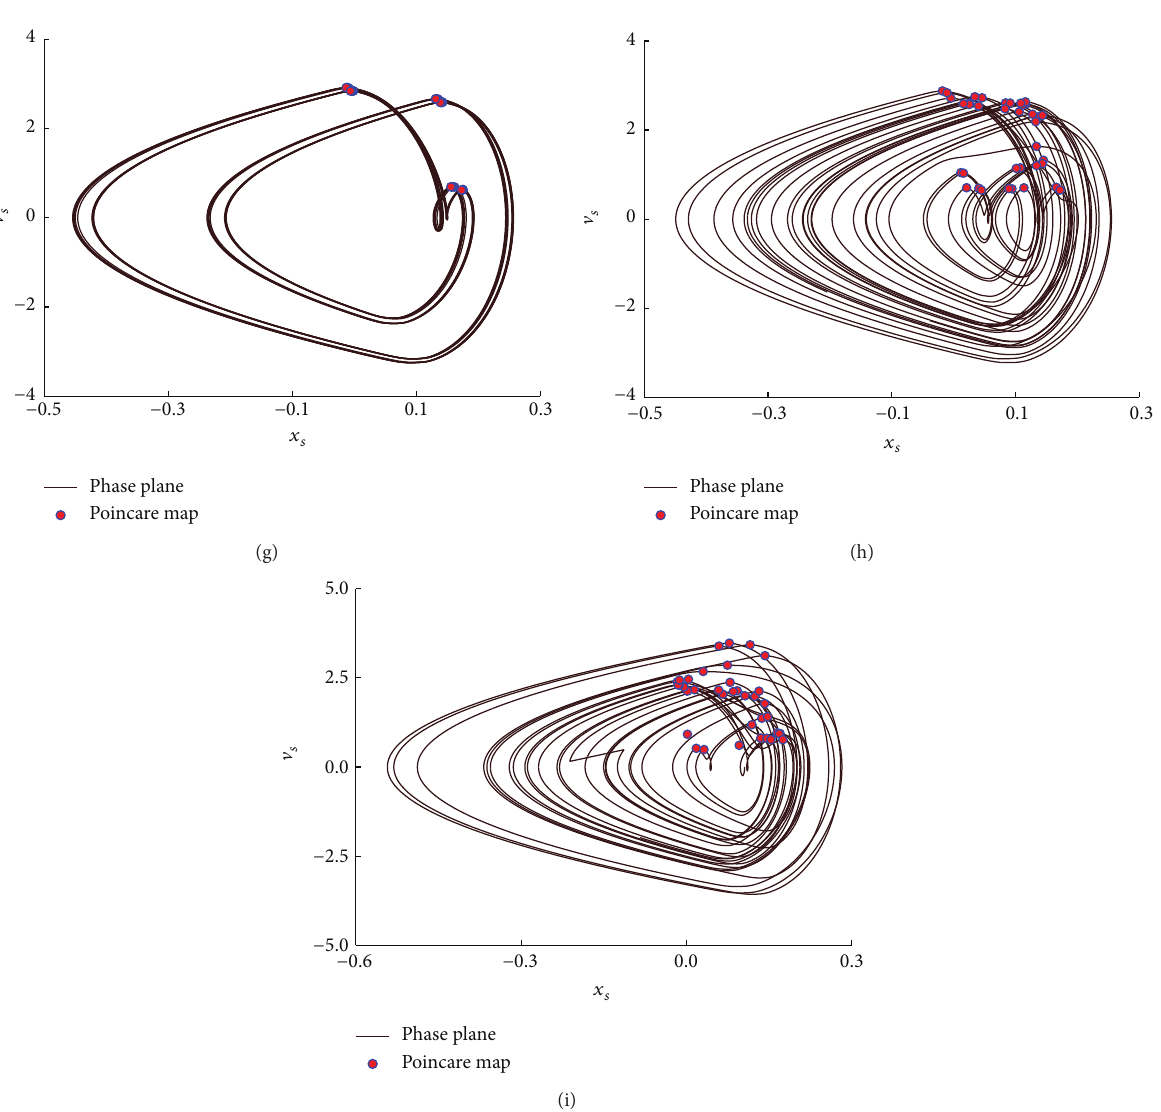
Figure6:PhaseportraitsandcorrespondingPoincaremaps(velocity V 𝑠 versusdisplacement 𝑥 𝑠 )fordifferent 𝑓 :(a) 𝑓 = 1 .5 Hz; (b) 𝑓 = 2 .2 Hz; (c) 𝑓 = 2 .39 Hz; (d) 𝑓 = 2 .245 Hz; (e) 𝑓 = 2 .471 Hz; (f) 𝑓 = 2 .8 Hz; (g) 𝑓 = 3 .071Hz; (h) 𝑓 = 3 .2 Hz; (i) 𝑓 = 3 .75